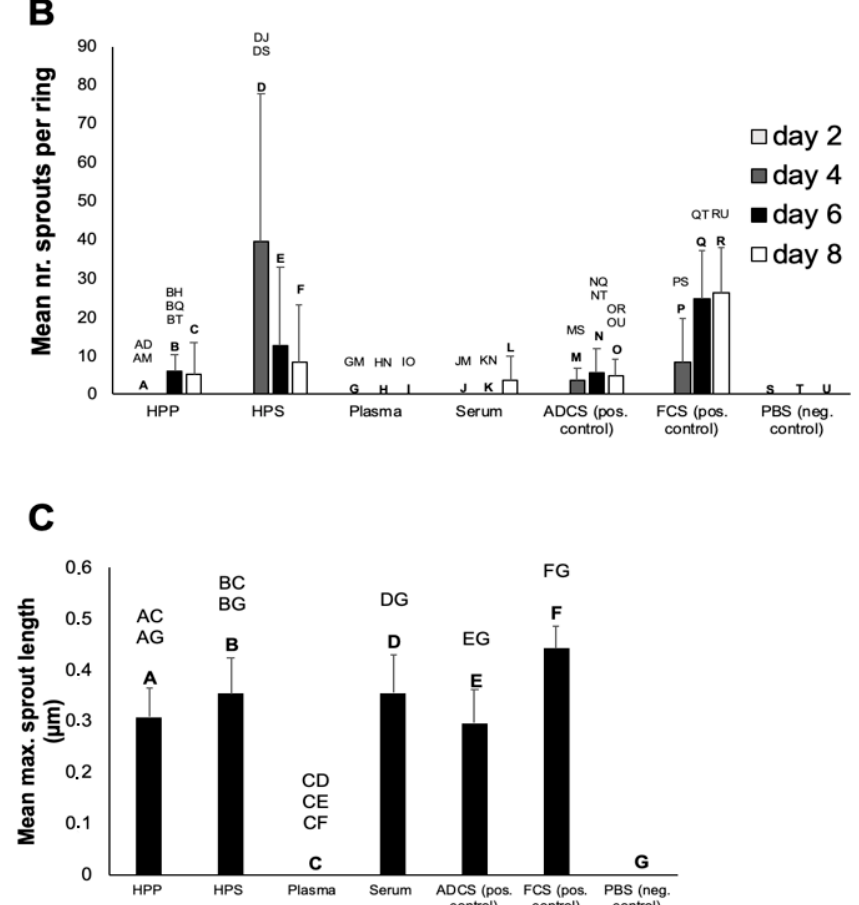
Figure 5. E ff ect of blood-derived secretomes on lymphatic sprouting in the thoracic duct ring assay. ( A ) Panel showing representative images of thoracic duct ring cultures (8 days culture), carried out in the presence of blood-derived secretomes (hypoxia preconditioned plasma (HPP) and serum (HPS), normal plasma and serum), as well as positive controls (adipose-derived cell suspension (ADCS) and fetal calf serum (FCS)), and negative control (phosphate bu ff ered saline (PBS)) samples. Enlarged image sections are indicated by red insets. (Bars = 100 µ m). ( B ) Plot showing the mean number of lymphatic sprouts formed in di ff erent culture conditions (2, 4, 6 and 8 days culture), as described above ( n = 3). ( C ) Plot showing the mean maximum lymphatic sprout length ( µ m) after a culture period of 8 days ( n = 3). Capital letter pairs over plots indicate statistical comparison of corresponding data points. For all pair comparisons, p < 0.05, unless otherwise indicated.